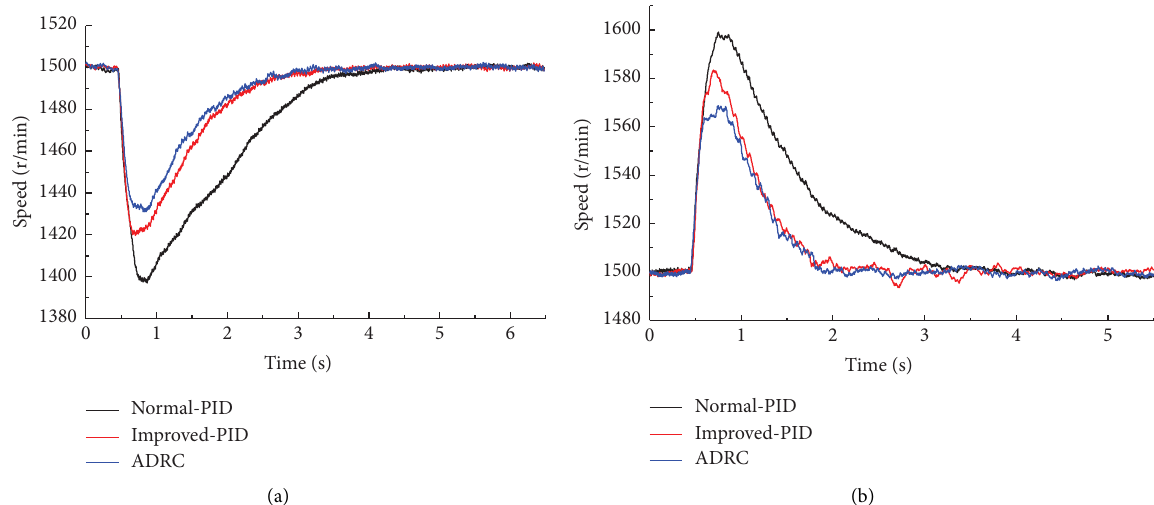
Figure 22: Comparisons of the experimental results for the three control algorithms (the target speed is the rated speed 1500 r/min). (a) Sudden load process. (b) Sudden unload